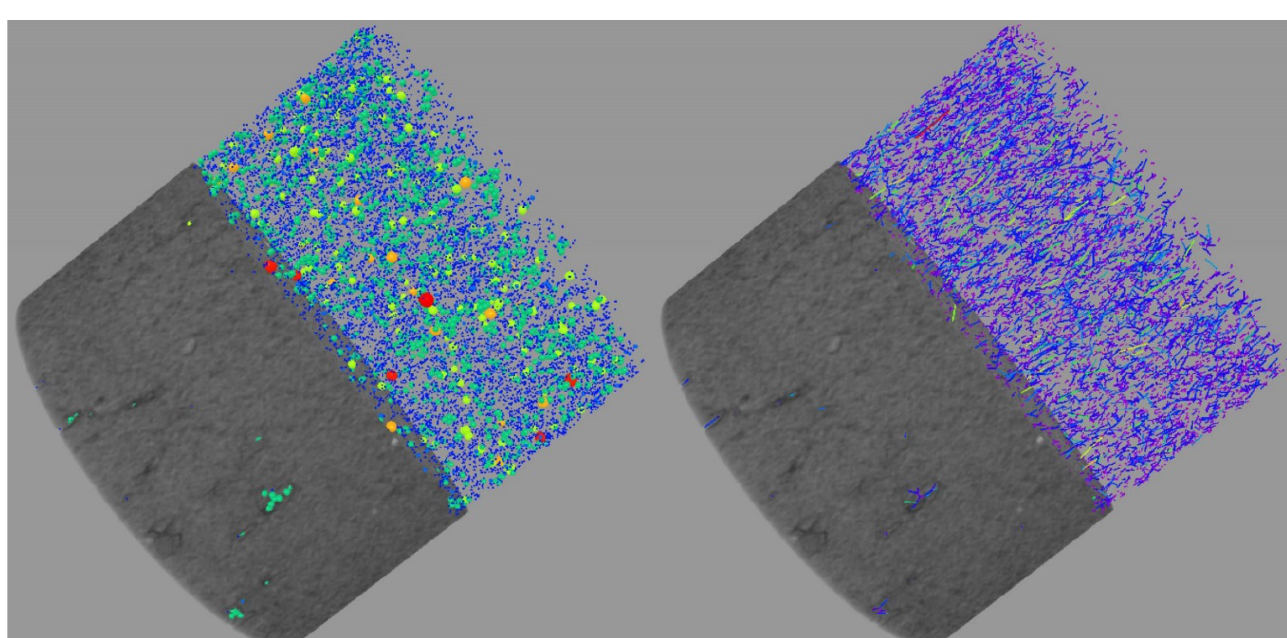
Figure 2. The cylindrical ROI of one of the samples from ceramic 4, viewed from one end ( left ); the same ROI segmented with a deep learning model based on sensor 3D architecture to separate pores (marked as blue here) from silica-rich particles (marked as red) and ceramic matrix (marked as yel- low) ( center ); and an ROI with only pores (18.7 vol.%) visible ( right ).